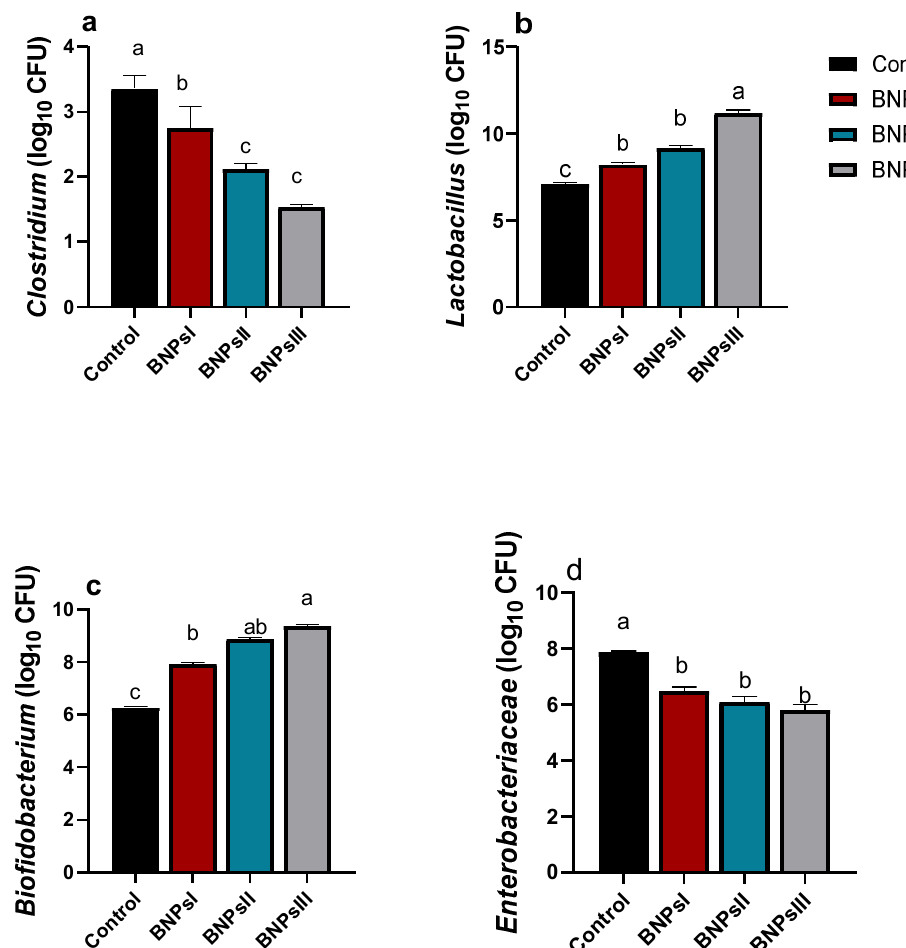
Figure 3. Effect of feeding Ross broilers ( n = 5/group) different levels of Bacillus amyloliquefaciens - encapsulated nanoparticles (BNPs I, II, and III) on the intestinal microbial populations compared to birds fed basal diet. Graphs represented the counts of Clostridium ( a ), Lactobacillus ( b ), Bifidobacterium ( c ), and Enterobacteriaceae ( d ) expressed as log 10 of the CFU/g of the sample and the significance is p < 0.05. a–d Mean values within columns showing numerous letters differ statistically.